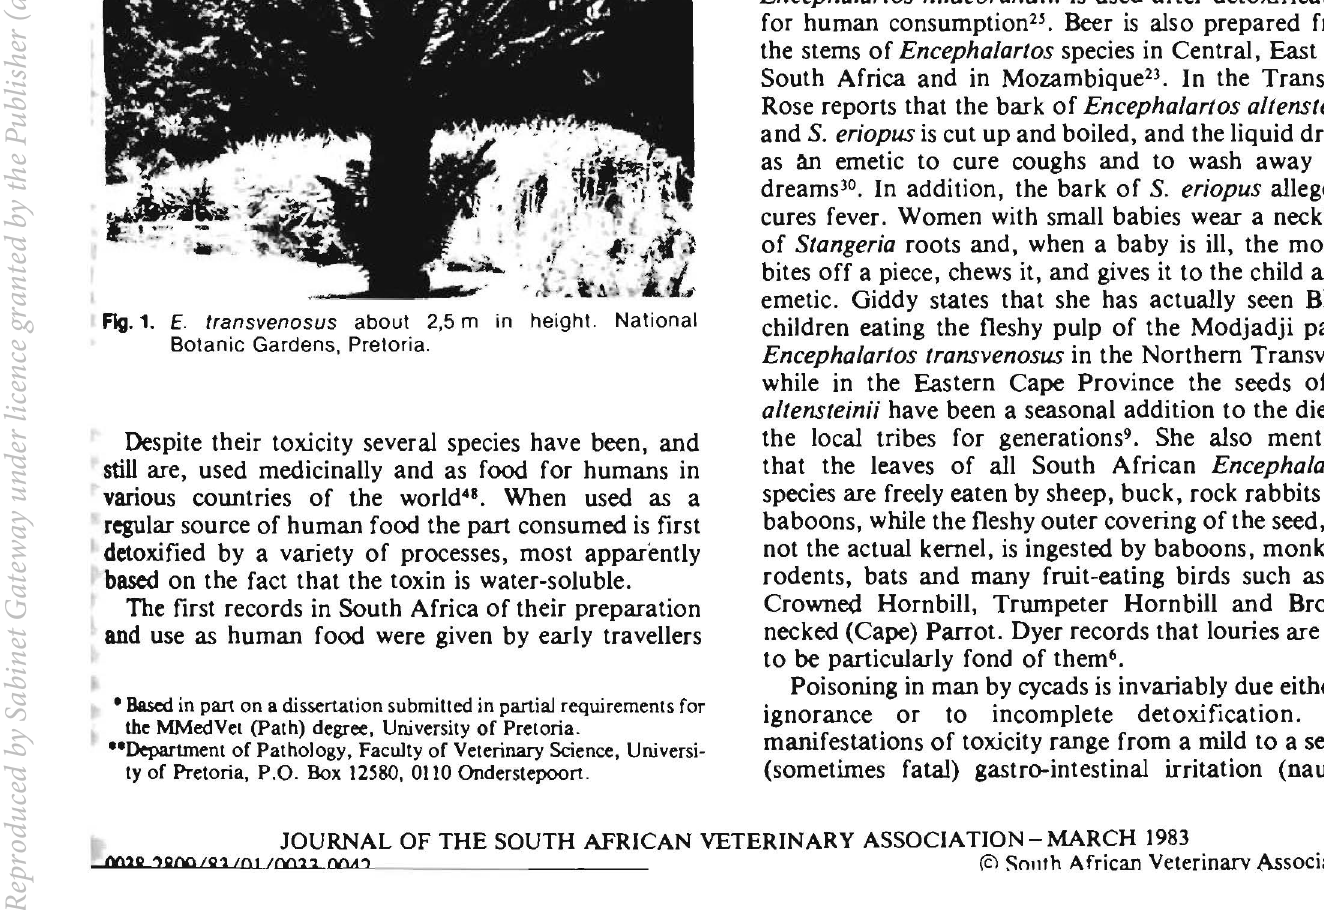
Despite their toxicity several species have been.